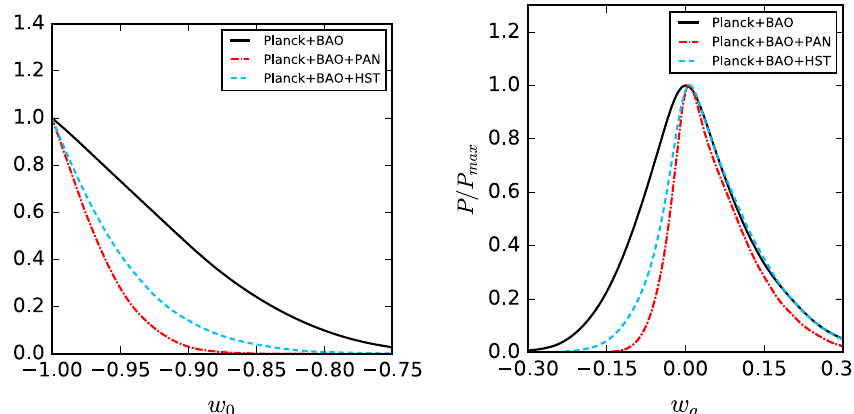
(95% CL) required for inverted hierarchy of neutrino masses and is stronger than a bound of CL) obtained in (cid:2) CDM +